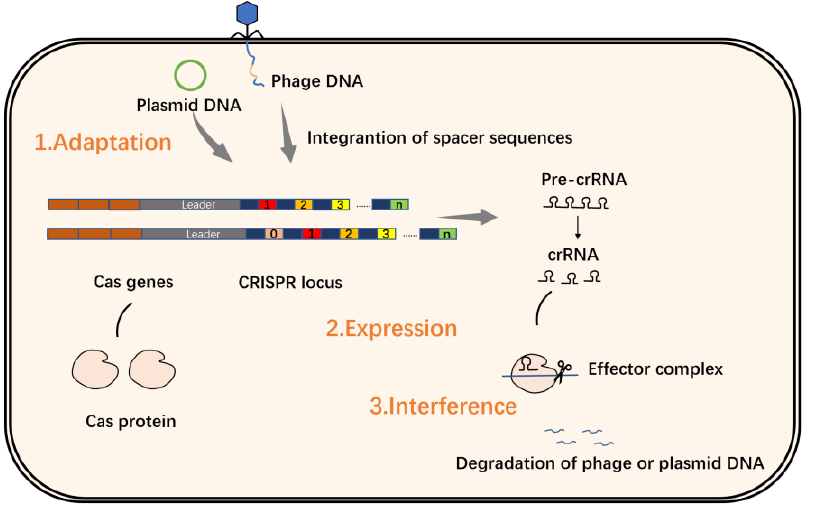
Figure 2. The CRISPR/Cas system in action during the adaptation phase, short DNA fragments that are homologous to the viral or plasmid sequence are integrated into the CRISPRs site as spacers; during the expression stage, the CRISPRs sequence is first transcribed into pre-crRNA, which is then processed into crRNA that matches the target sequence of the virus or plasmid; during the interference phase, the crRNA guides the Cas protein to the target sequence of the virus or plasmid that matches the spacer, forming an effector complex, and then the cleavage ability of the Cas protein degrades the phage or plasmid DNA.